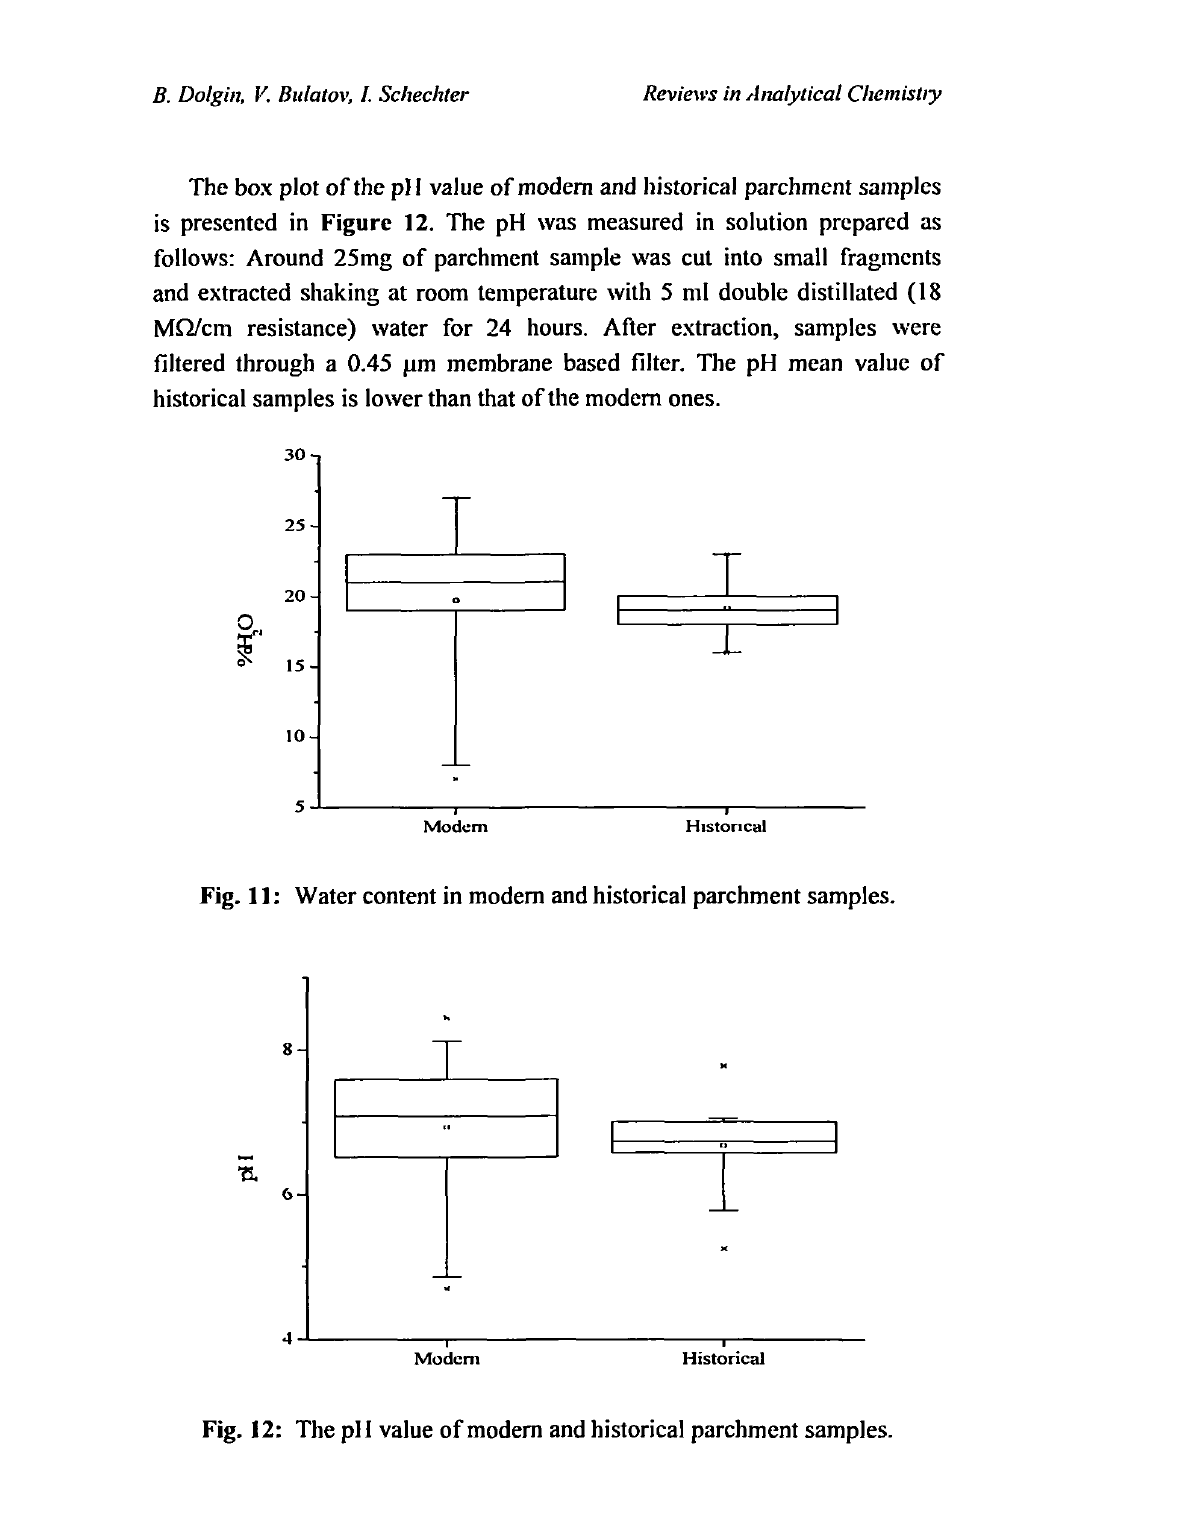
Fig. 12: The pi I value of modern and historical parchment